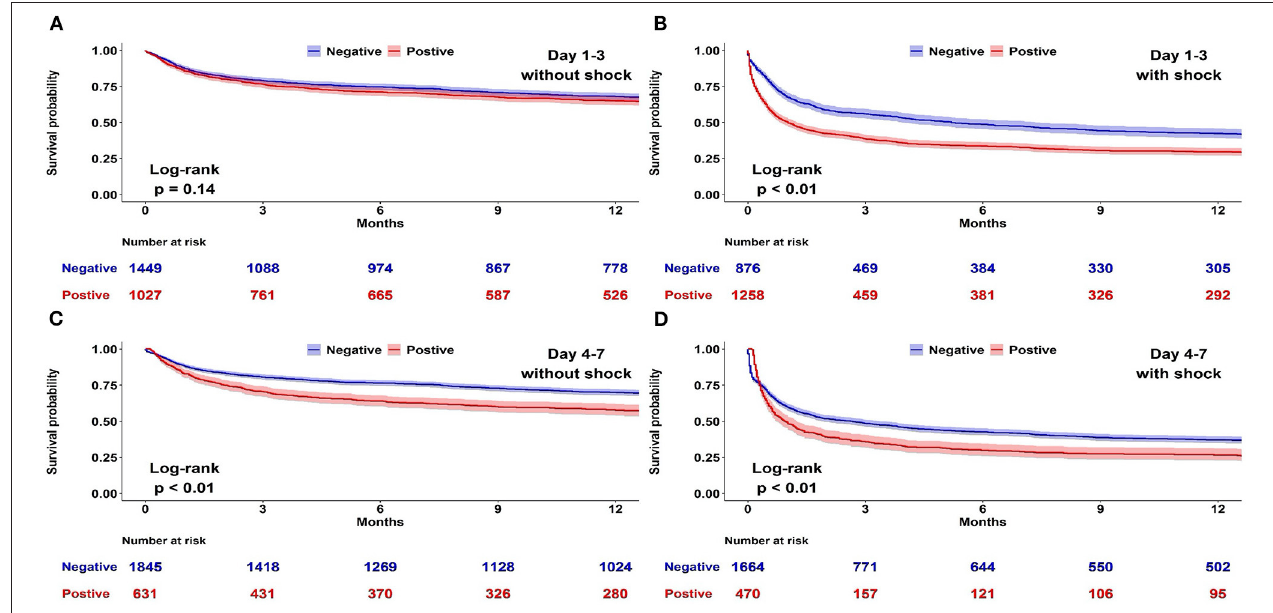
FIGURE 3 | Association between positive and negative cumulative fluid balance (CFB) and long-term survival stratified by shock status. Kaplan–Meier survival curves for negative and positive CFB among 4,610 patients admitted to medical intensive care units stratified by the presence of shock. (A) Day 1–3 CFB in patients without